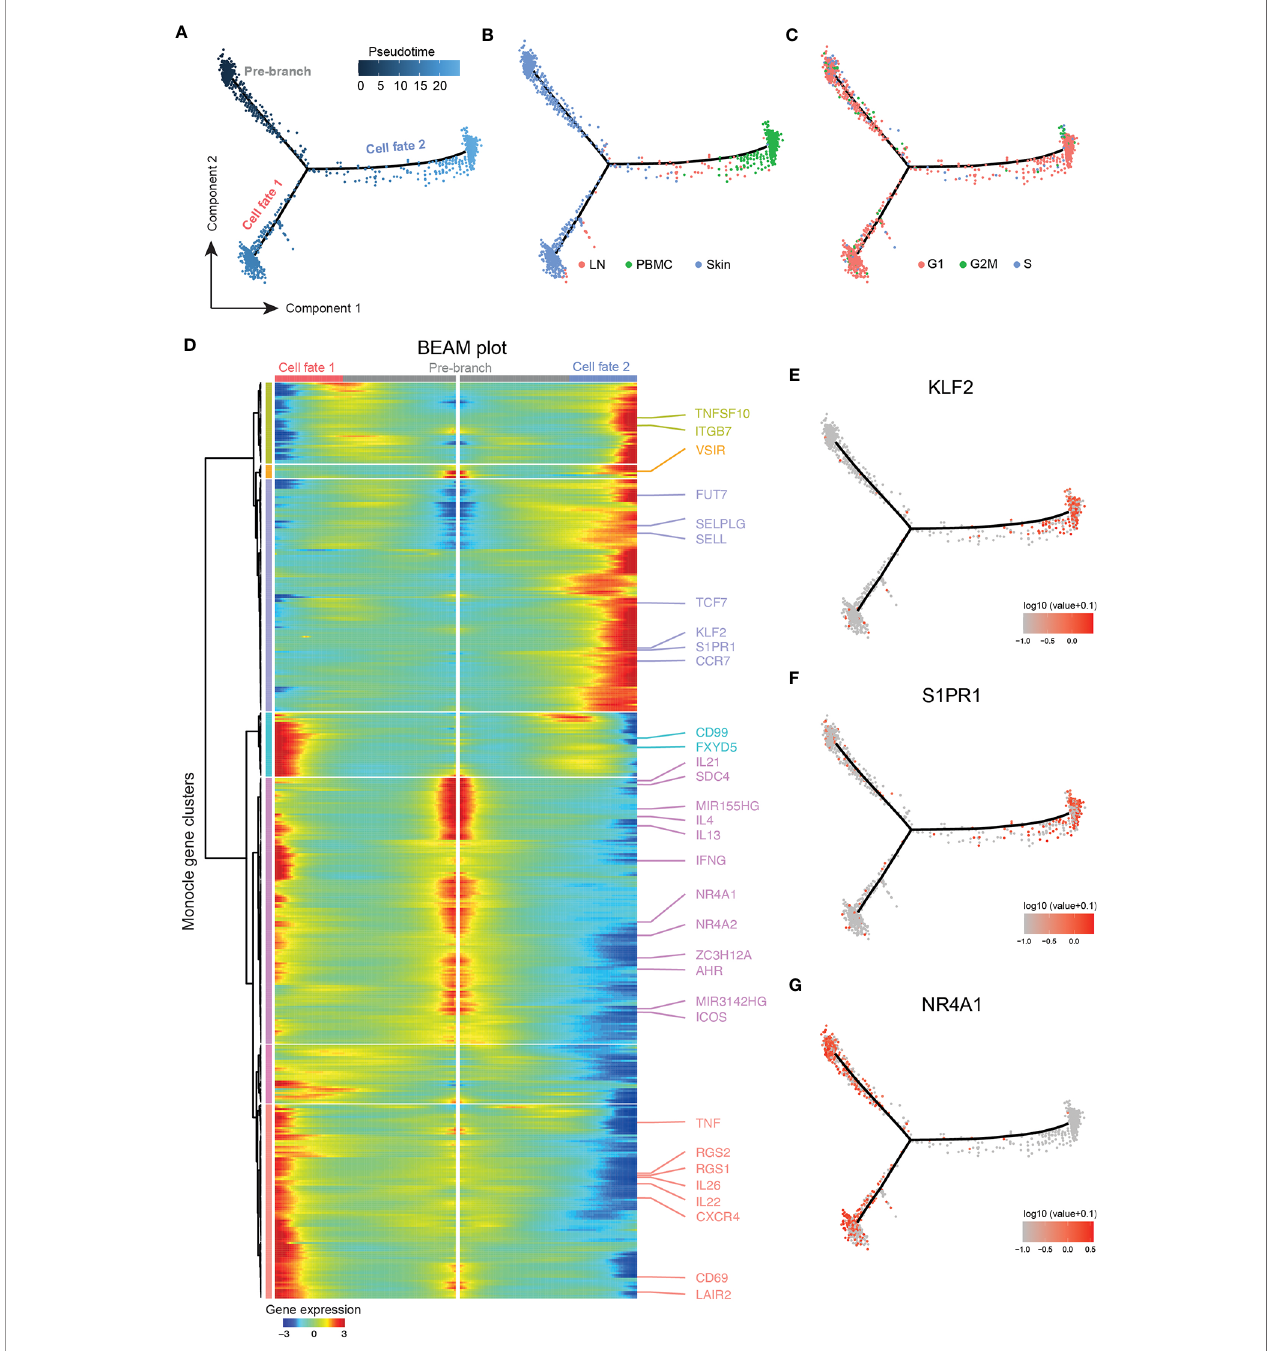
FIGURE 6 | Trajectory analysis highlighting tumor clone plasticity throughout body compartments. (A) Pseudotime ordering of malignant cells from clusters TC-1 and TC-3 along a bifurcated cell trajectory. Plot colored according to pseudotime. (B) Trajectory plot colored according to tissue of origin in red (LN: lymph node), green (PBMC, peripheral blood mononuclear cells), and blue (skin). (C) Trajectory plot colored according cell cycle phase in red (G1), green (G2/M) and blue (S). (D) Bifurcated expression heat map of genes for bifurcation between cell fates 1 and 2. Middle of heat map shows pre-branch cells, left side the expression of cells from “ cell fate 1 ” , and right side the expression blood-oriented cells ( “ cell fate 2 ” ). (E – G) Trajectory plots with overlaid expression of respective genes, highest expression in red, lowest expression in